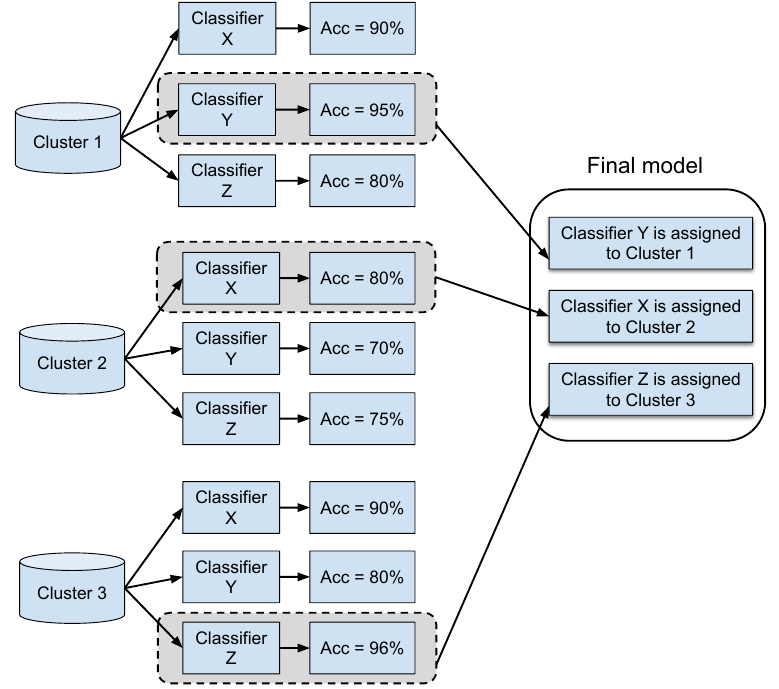
Figure 2. Example of the model development phase of the proposed